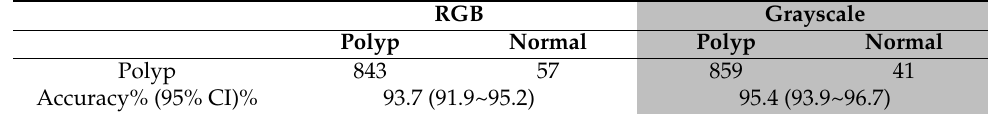
Table 6. CGMH-WL testing dataset of polyp detection.